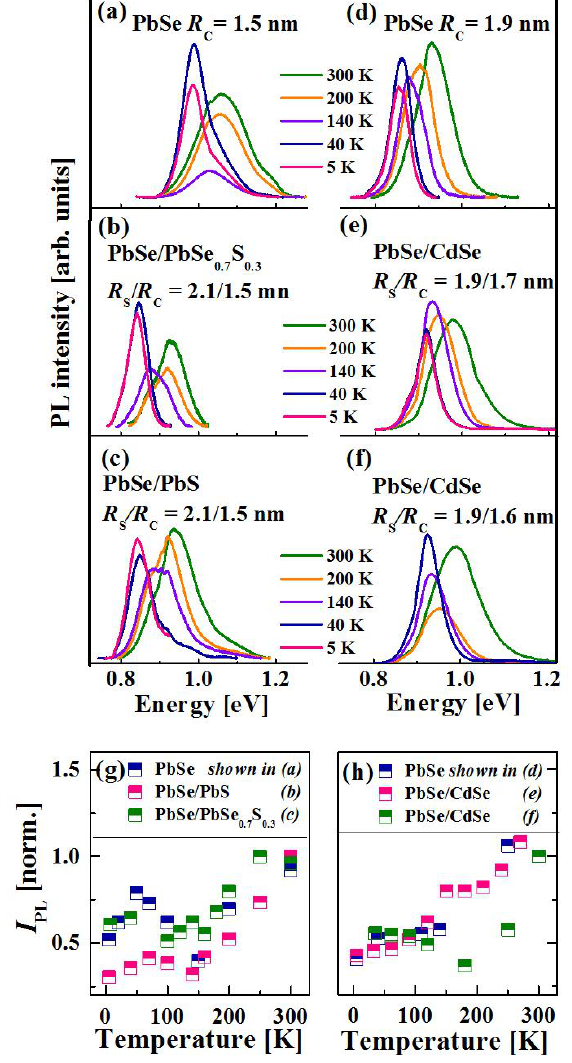
Figure 16. cw-PL spectra of air-free ( a ), ( d ) PbSe core; ( b ) PbSe/PbS core/shell; ( c ) PbSe/PbSe 0.7 S 0.3 core/alloyed-shell; ( e , f ) PbSe/CdSe core/shell QDs with different Rs/Rc values (see the legend); ( g , h ) plot of normalized cw-PL integrated intensity, I PL , vs. temperature for the same QDs as in ( a – f ), see the